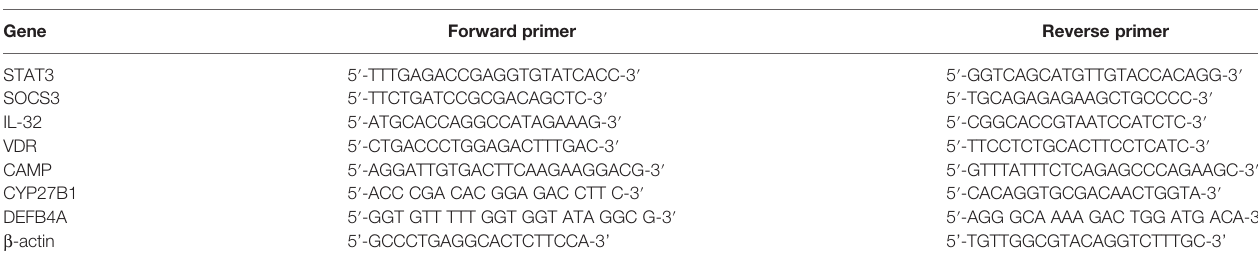
TABLE 1 | Primers used for